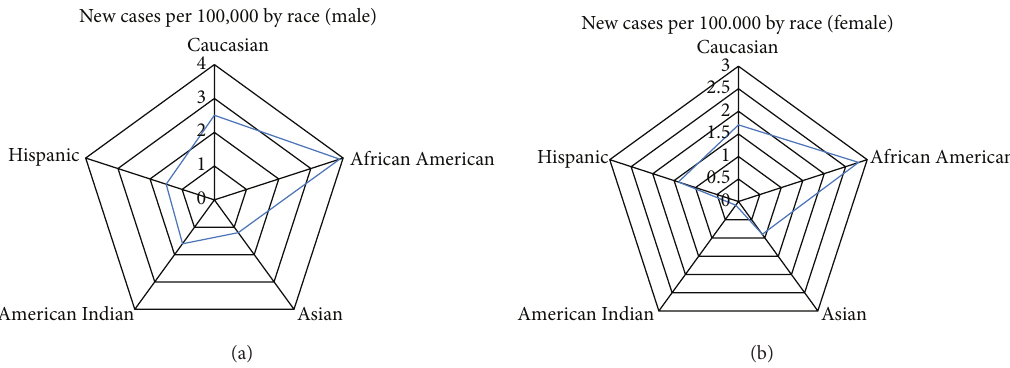
Figure 1: Graphs showing the incidence rate split between gender and race in the United States.